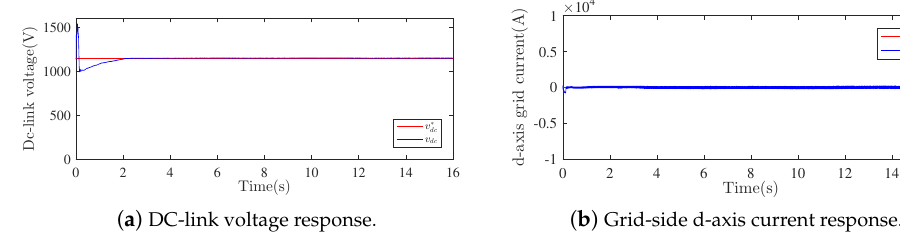
Figure 13. Grid-side results.